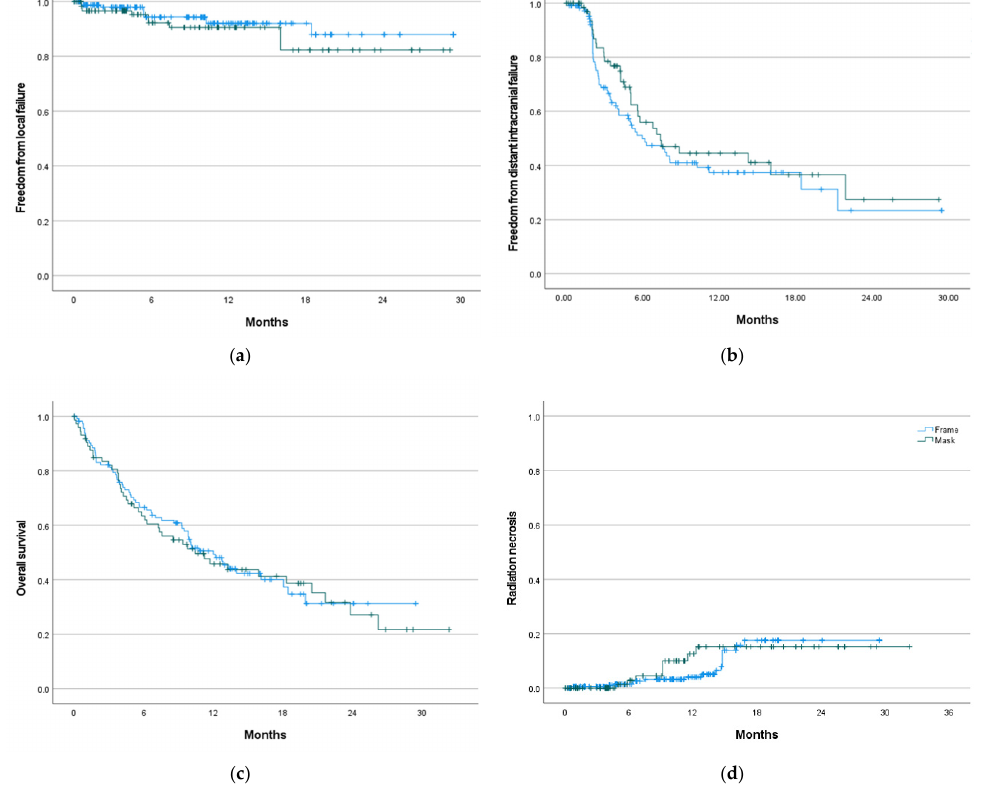
Table 2. Univariable and multivariable analyses for local failure.